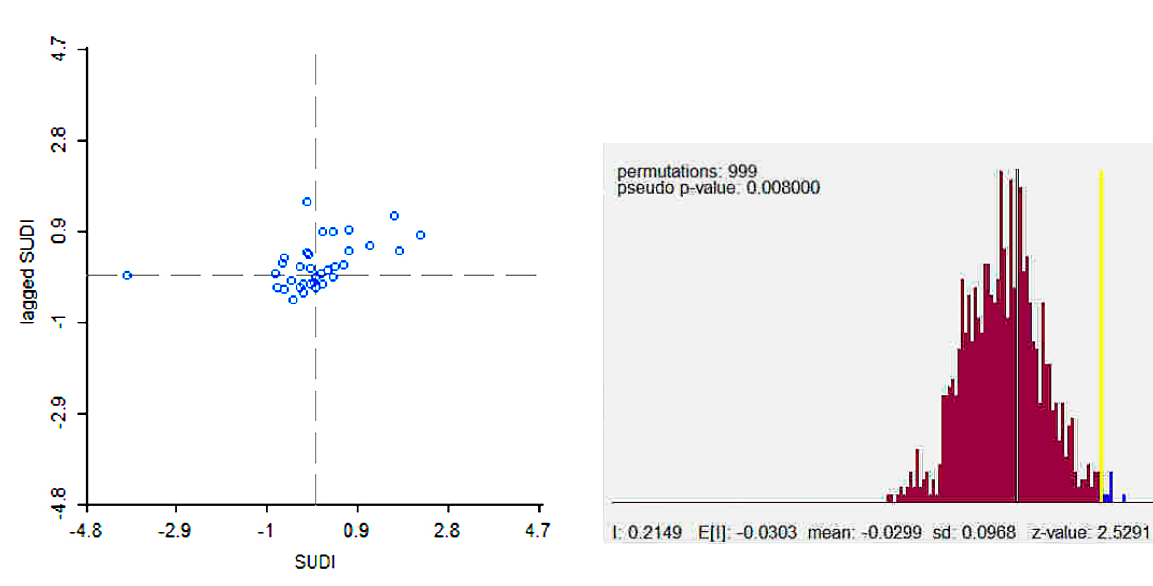
fig. 4. Spatial autocorrelation and pseudo significance